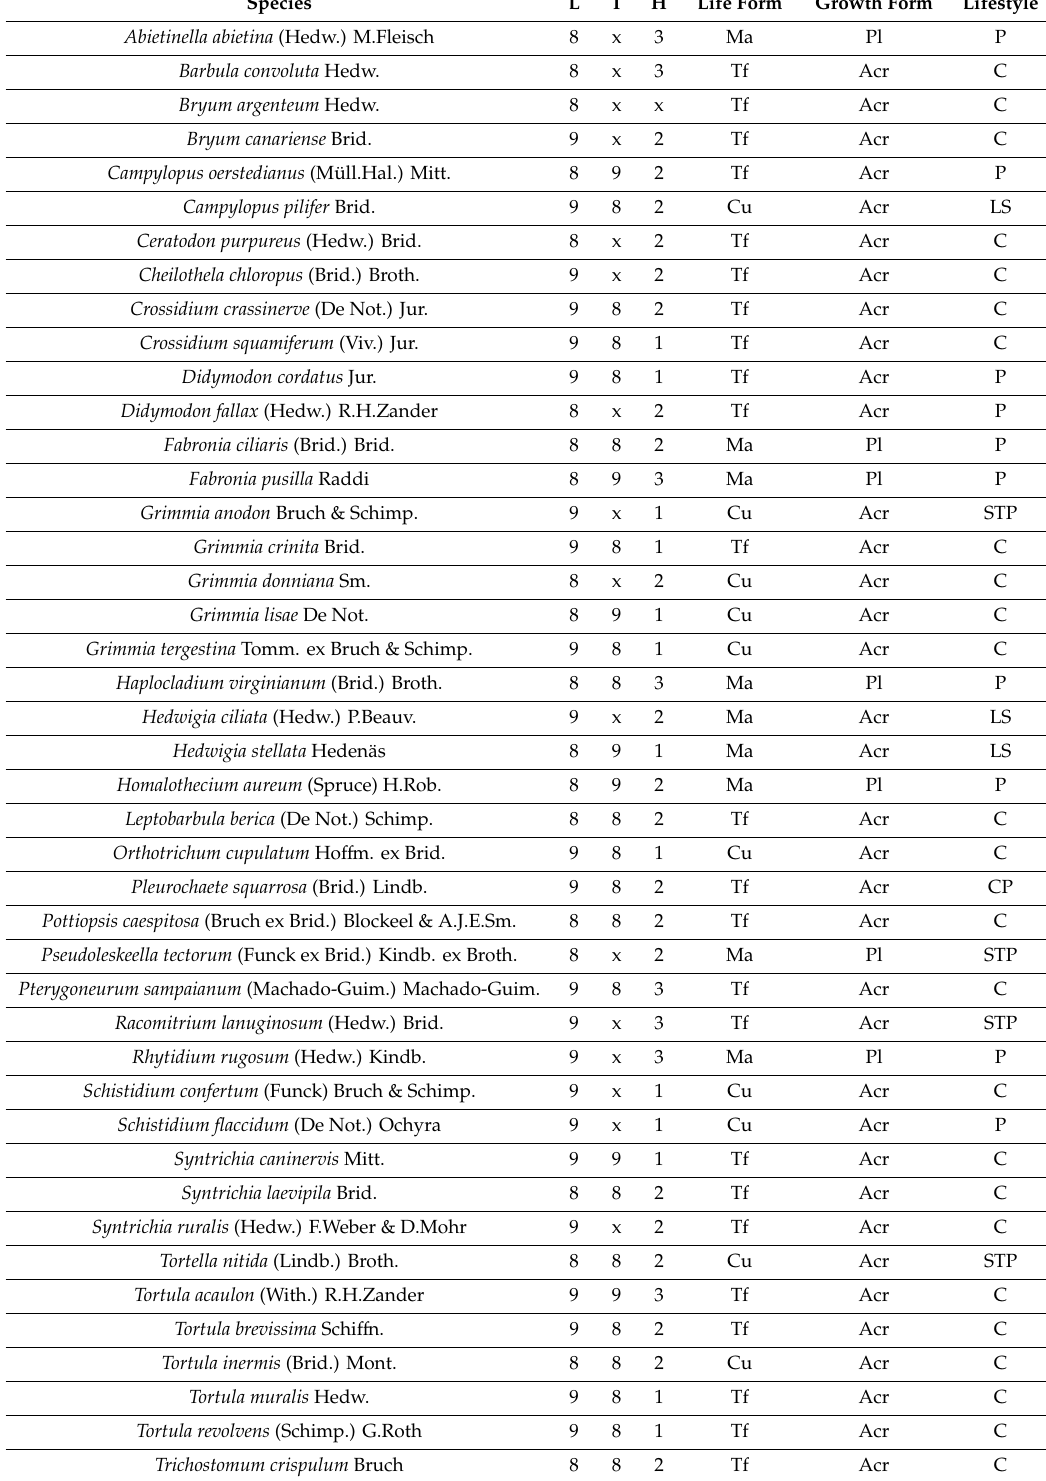
Table 1. List of potential moss species to be used in Mediterranean green roofs according to the selection method proposed in the current work using Ellenberg’s values for light (L), temperature (T) and humidity (H) [36]. (x—no specific ecological preference). Life form (Cu, cushion; Ma, mats; Tf, tuft), growth form (Acr, acrocarpous; Pl, pleurocarpous) and lifestyle (C, colonist; CP, competitive perennial; LS, long-lived shuttle; P, perennial; STP, stress-tolerant perennial) are also noted [37,38]. Species L T H Life Form Growth Form Lifestyle Abietinella abietina (Hedw.) M.Fleisch